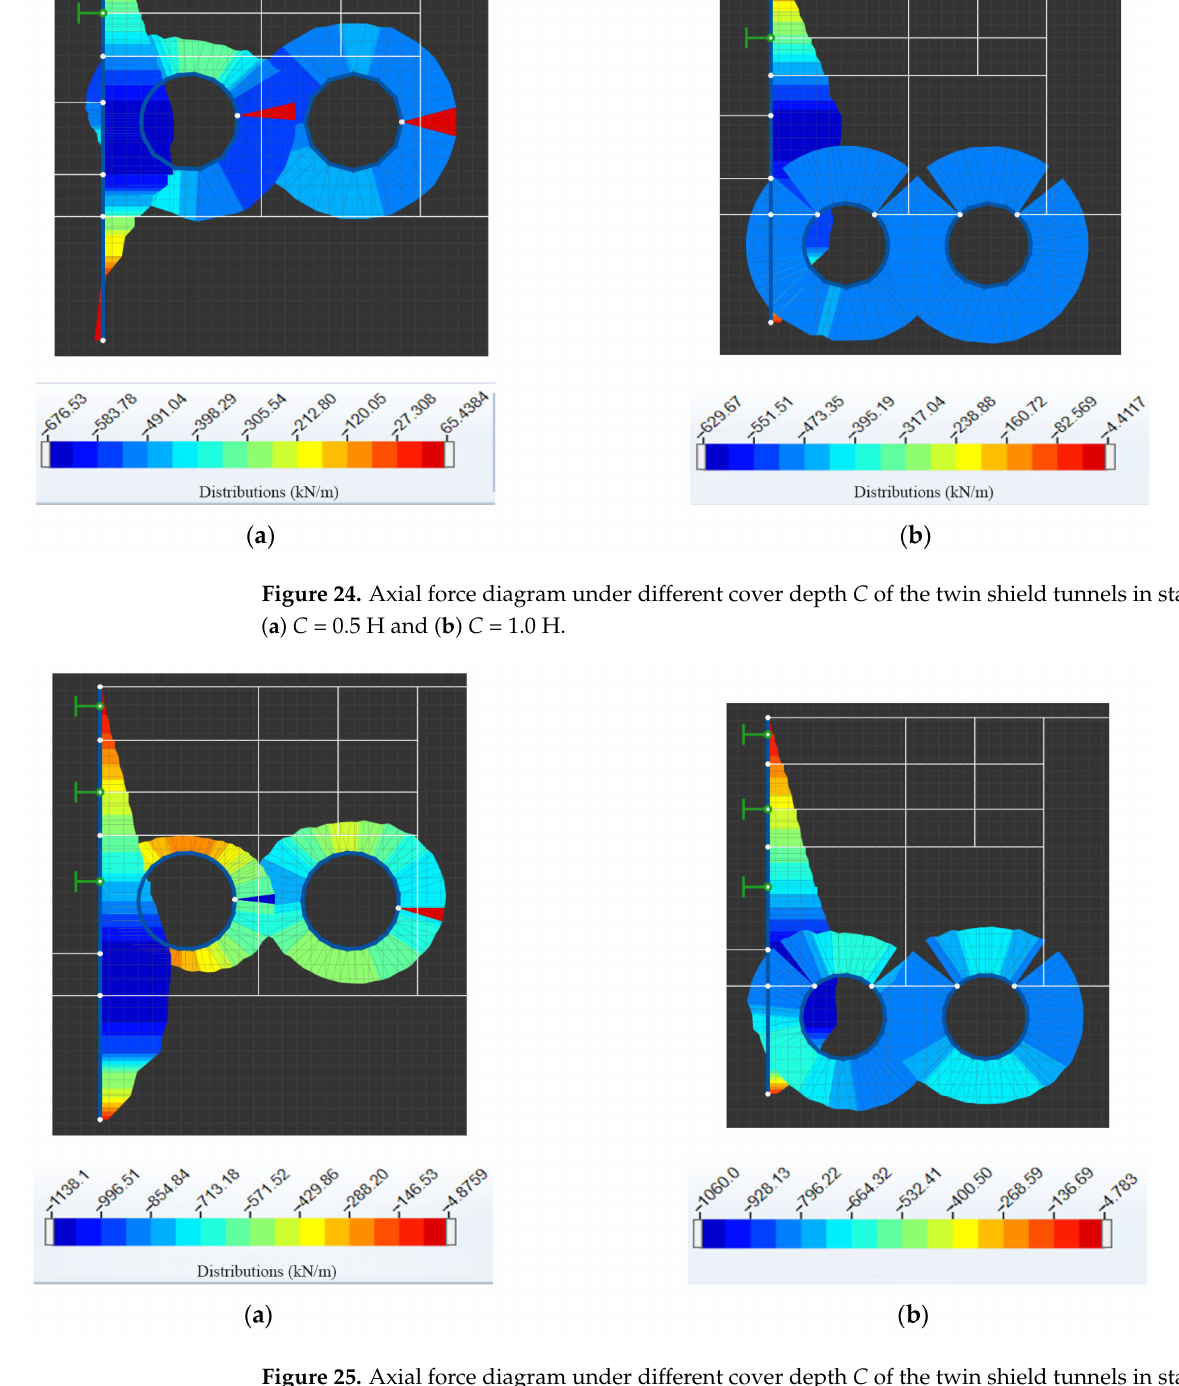
Figure 25. Axial force diagram under different cover depth C of the twin shield tunnels in stage (4): ( a ) C = 0.5 H and ( b ) C = 1.0